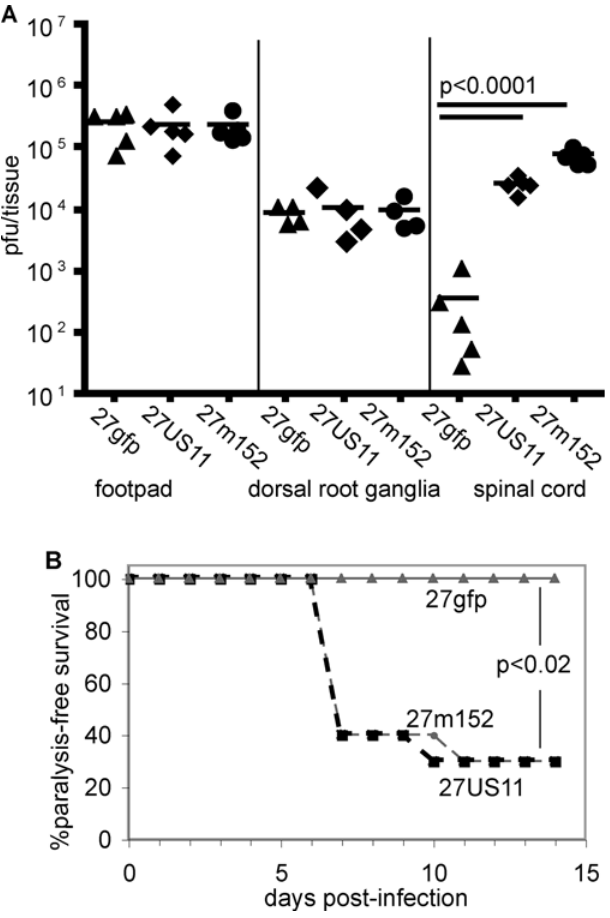
Figure 6. Inhibition of MHC Class I Increases Neuroinvasiveness and Neurovirulence BALB/c were infected in the hind footpads with 2.5 3 10 5 pfu of 27gfp, 27US11, or 27m152. (A) The indicated tissues were isolated on day 6, homogenized, and viral titers were determined on vero cells. (B) Ten mice per virus were monitored for paralysis induction for 14 d. Mice displaying ataxia or paralysis were euthanized. DOI: